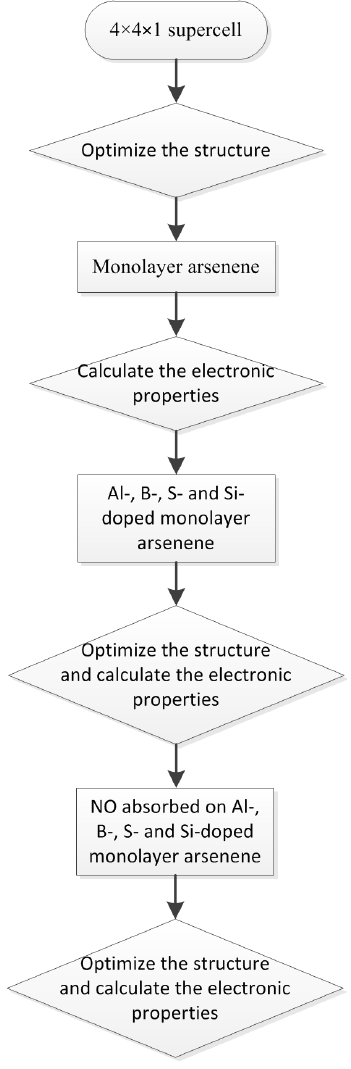
Figure 1. The flow chart of the computational process.